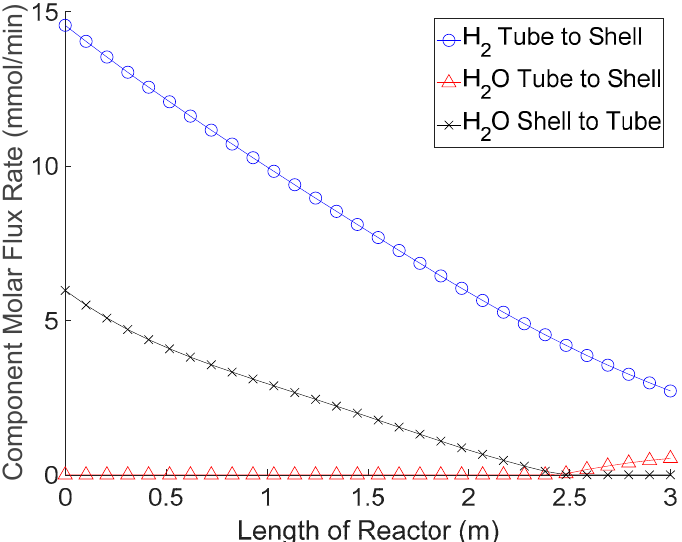
Figure 11. Flux profile for the “best compromise” operating condition (syngas-to-steam ratio = 0.92). Unlike the simulation in Figure 10a, the process did not hit an equilibrium point where all potential H 2 recovery is completed. This means that although CO 2 is still being lost to the shell side, H 2 is also being recovered. Another improvement is that the steam injection process is completed before reaching the end of the membrane reactor. Taking what was learned from Figure 10b, this avoids